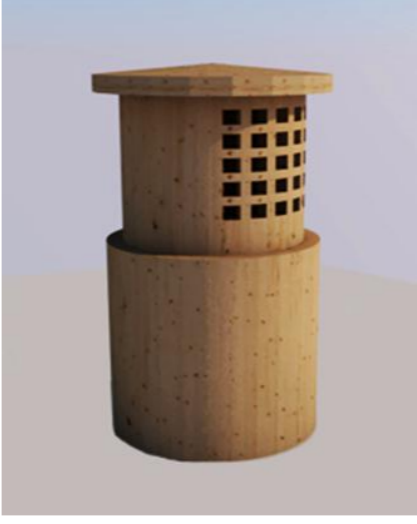
Figure 4. A view of the proposed wind tower design